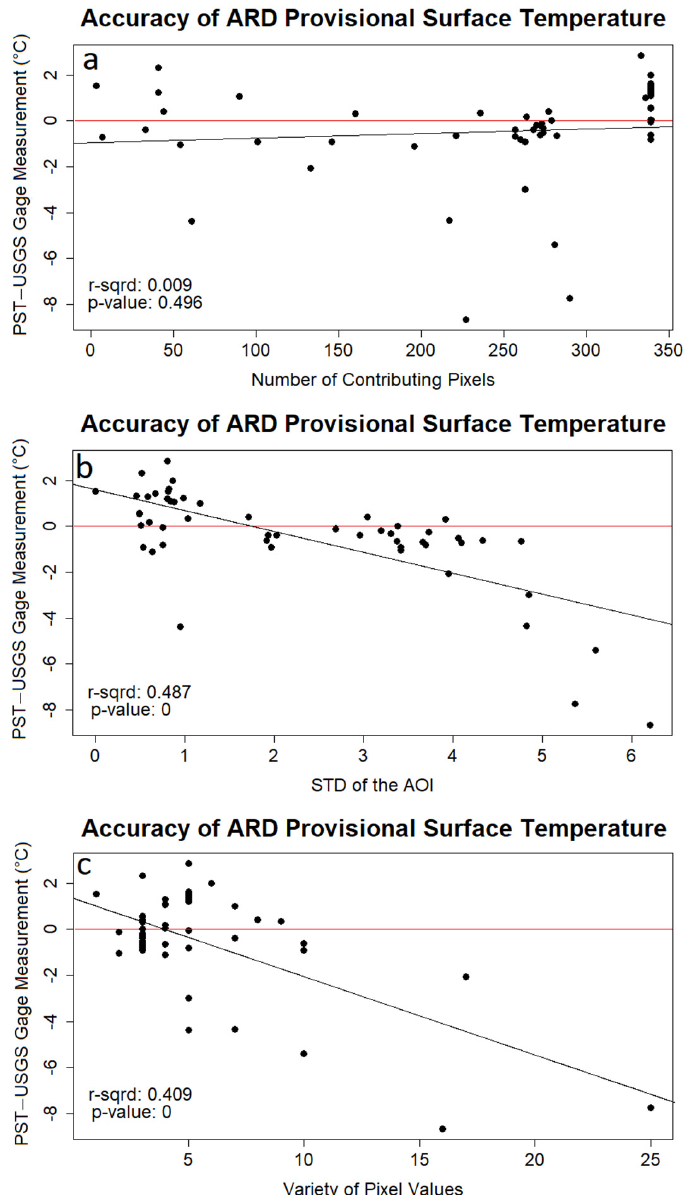
Figure 5. Scatter plots showing how the attributes of ( a ) quality pixel count, ( b ) standard deviation (STD) of the mean estimate, and ( c ) variety of quality pixel values are correlated with the agreement between the estimated and observed water temperature.